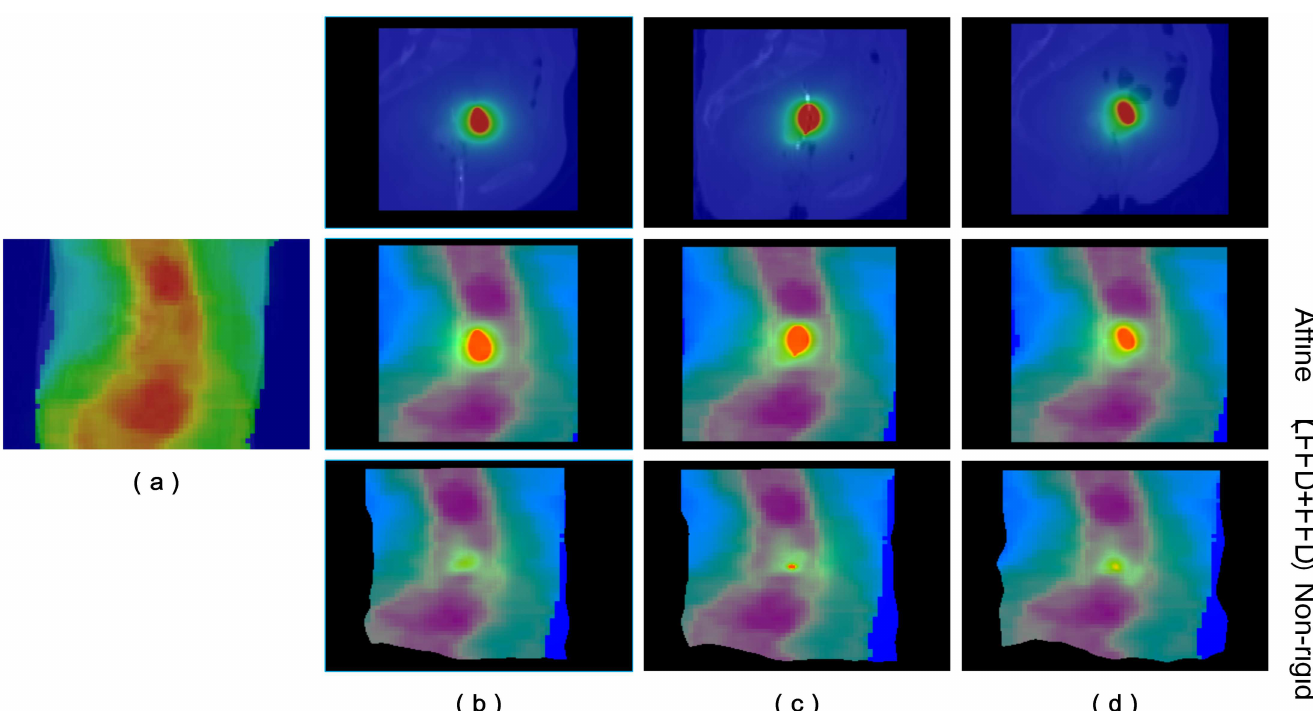
Fig 10. EBRT and HDR-BT dose accumulation in cervicalcancer. (a) EBRT dose distributionused as a reference. The first, second, and third HDR-BT dose distributionsand the accumulateddose distributionsafter affine and non-rigid(LFFD+FFD) registration are shownin columns(b)–(d).